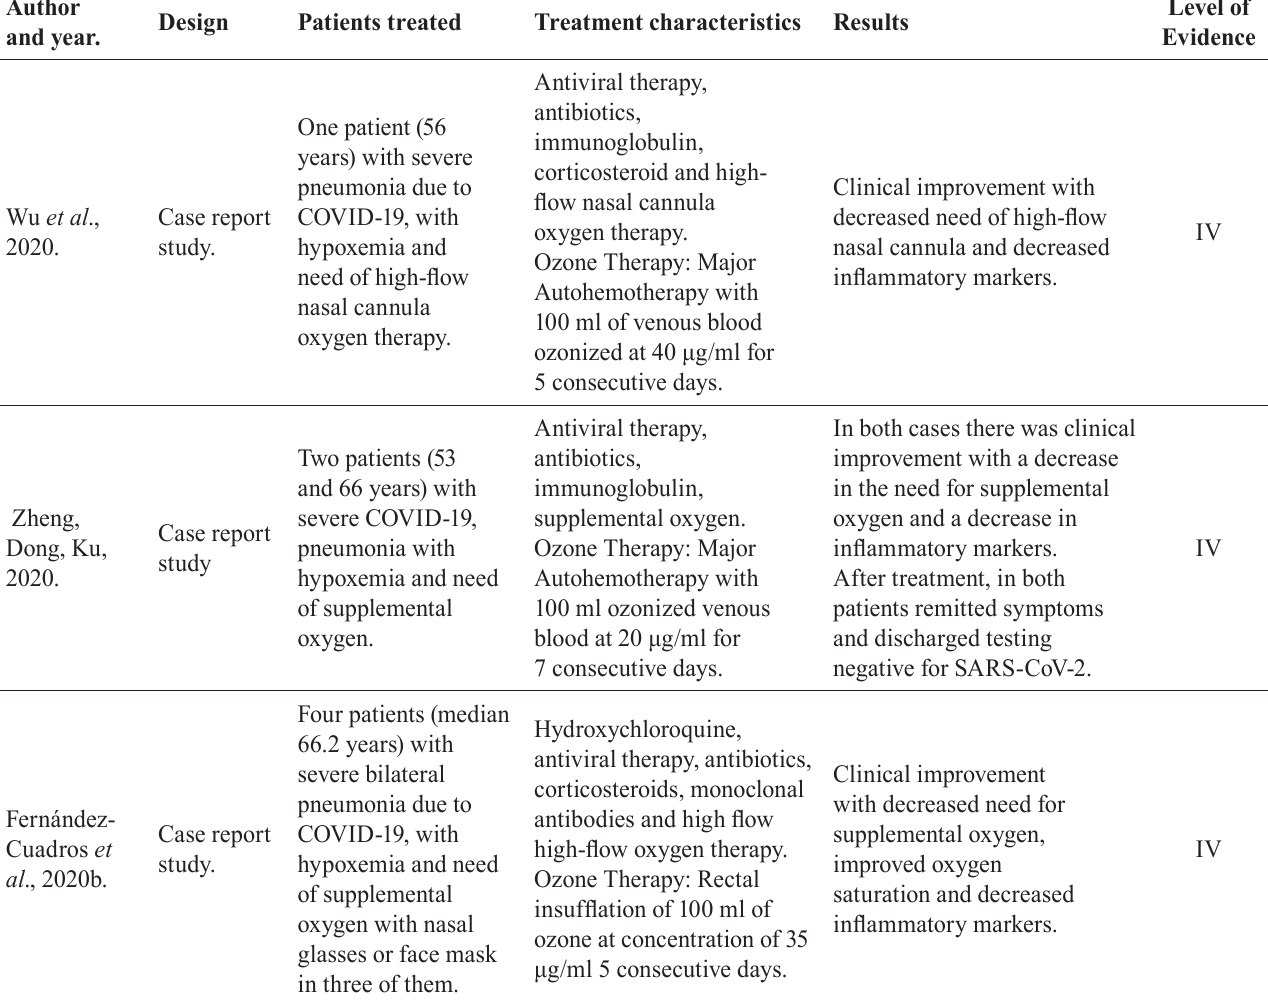
TABLE I - S ummary of clinical studies that were included in this systematic